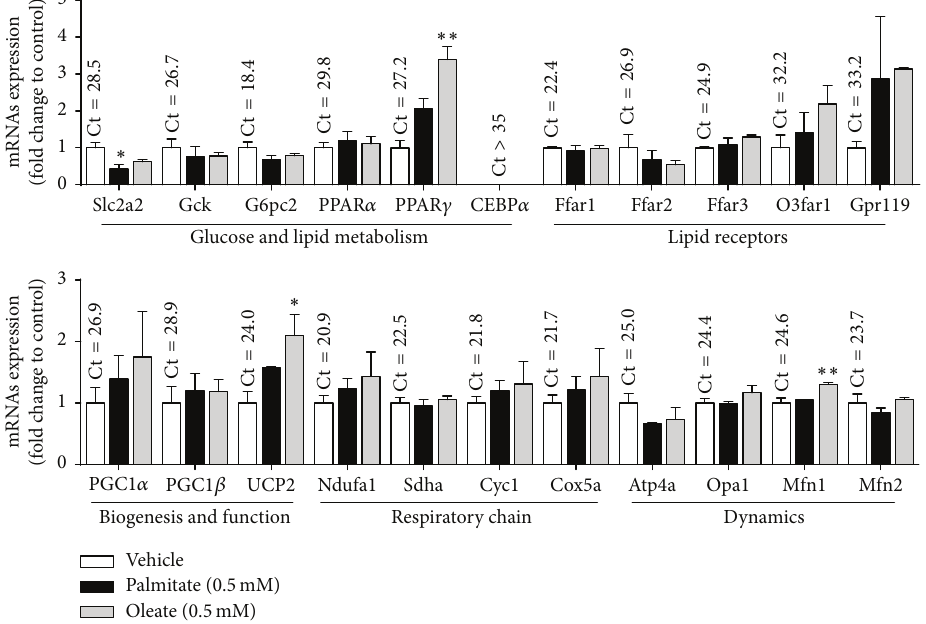
Figure 3: mRNA expression of energy metabolism-related genes in NEFAs-treated MIN6 𝛽 -cells. MIN6 𝛽 -cells were treated during twenty- four hours with palmitate or oleate (0.5 mM). Then, total RNA was extracted and the mRNA levels of genes related to glucose and lipid metabolism and with mitochondrial function were evaluated by RT-qPCR. The mRNA levels are expressed as fold change in 2 −Δ Ct of the specific gene in the treated versus control conditions (see Section 2). Graph bars represent mean ± standard errors of measurements of three independent experiments in triplicate. The numbers above bars represent the mean Ct value in control cells. The symbol ∗ denotes 𝑝 < 0.05 and ∗∗ denotes 𝑝 < 0.01 in one-way